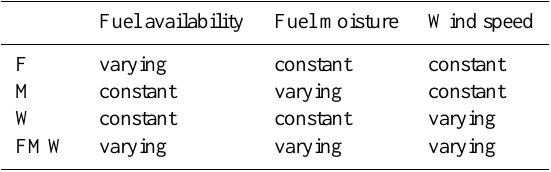
Table 1. Experiments performed for this study that keep single forc- ing factors controlling simulated fire activity constant or varying over the simulation period 8000 to